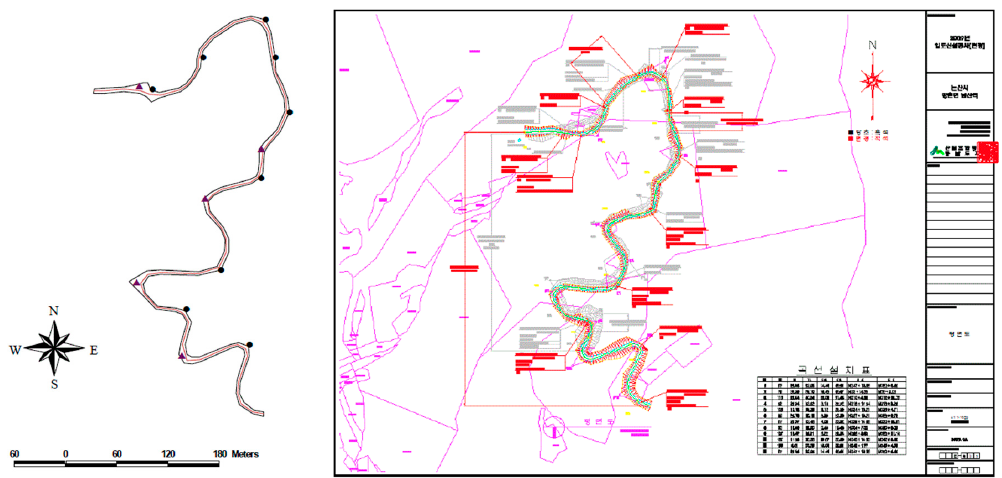
Figure 2. Examples of the reference map using the total station (left, ▴ GCP, — centerline of forest road) and conversion from the as-built drawing file to DXF file format (right).